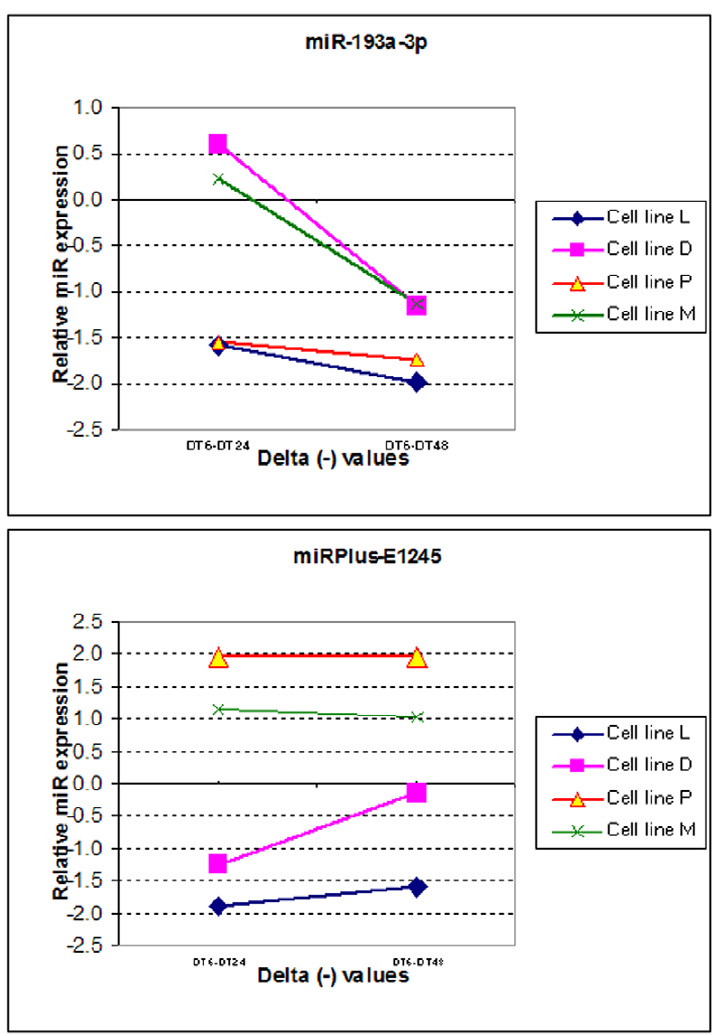
Figure 6. Differential expression of miR-193a-3p and miRPlus-E1245. By subtracting the miR expression values from the virus-infected and mock-infected (M-V) and further subtracting the values between the time points ( n T6 n T24 and n T6- n T48) an expression profile was generated for the two miRs as mentioned above. It can be observed that miR-193a-3p is down regulated over time due to virus infection in all 4 cell types, whereas miRPlus-E1245 exhibits varied levels of expression profile between the 4 cell types.